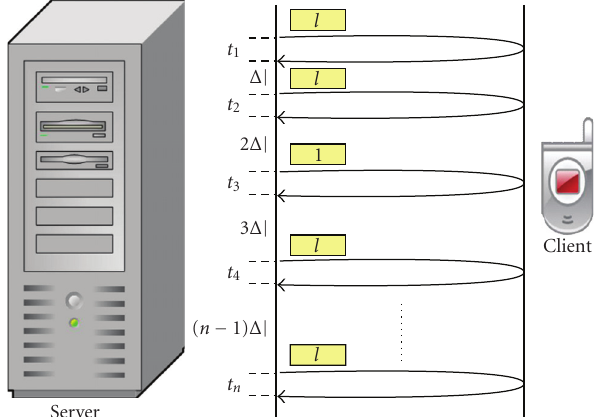
Figure 3: Measurement of response